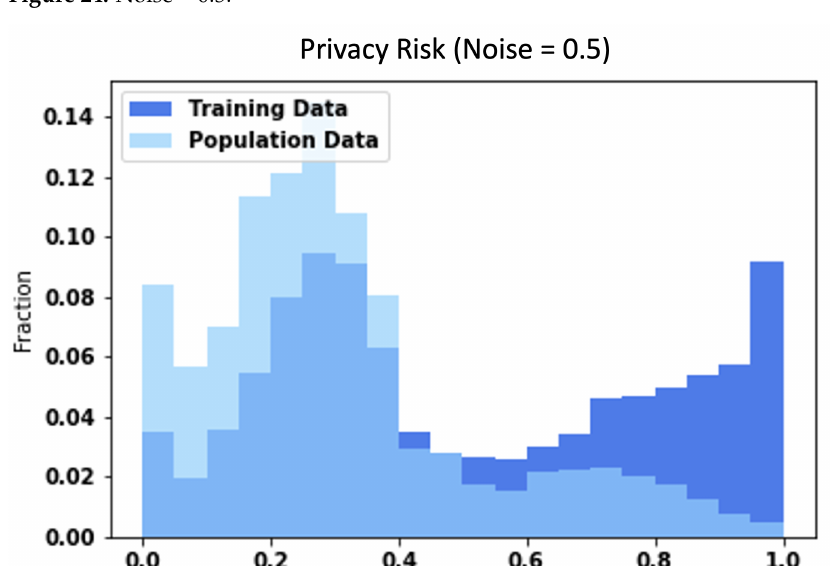
Figure 24. Noise = 0.3.